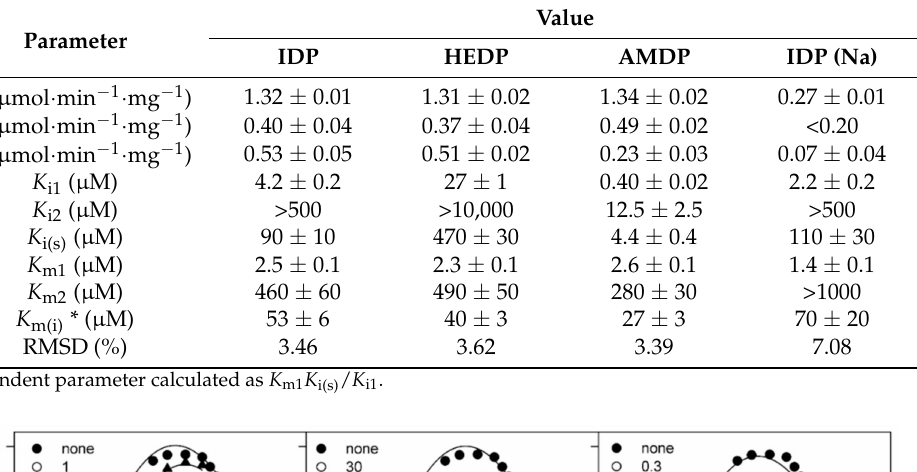
Table 1. Kinetic parameters for Dh-mPPase inhibition by substrate analogs according to Scheme 2. Free Mg 2+ concentration was maintained at 5 mM, and substrate (Mg 2 PP i ) concentration was varied in the range of 0.5–1100 µ M. The alkali metal cofactor was 50 mM K + , except for the column marked “IDP (Na),” for which it was 50 mM Na + . The K i values are shown in terms of total concentrations of the substrate analogs.